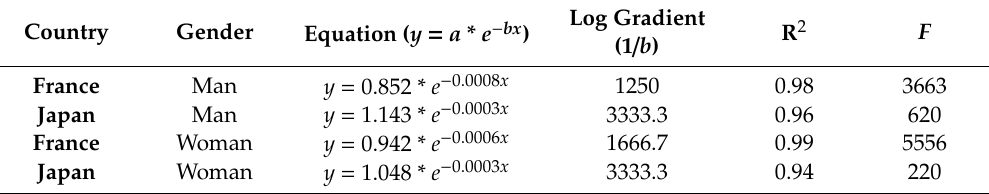
Table 4. Equation and statistical values of survival curves for waiting time according to the country and the gender of crossing pedestrians. All p -values are <